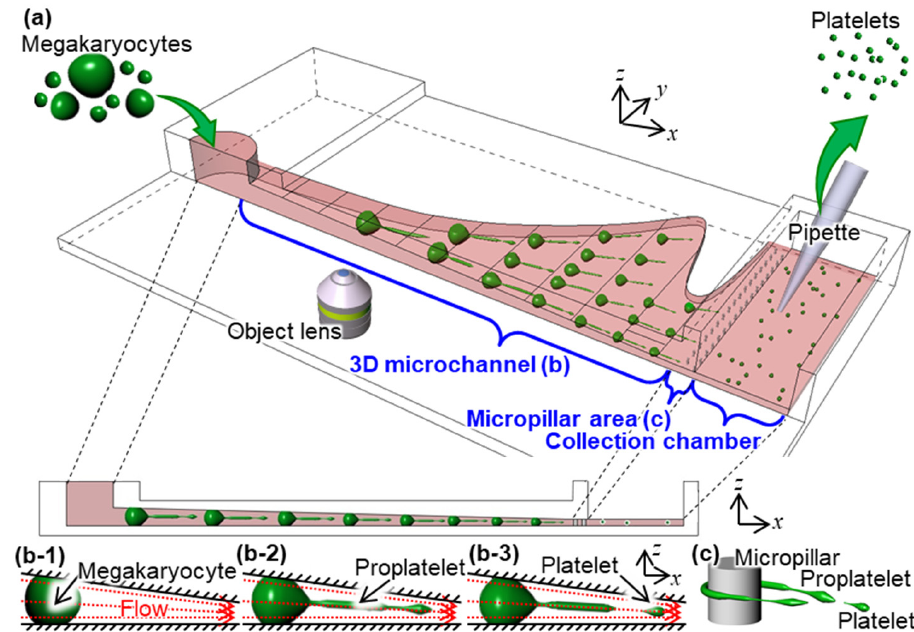
Figure 1. On-chip PLT production using a 3D microchannel. ( a ) Conceptual image of the microfluidic bioreactor, ( b ) Procedures of PLT production of ( b-1 ) The trapping of an MK, ( b-2 ) The elongation of an MK to a PPLT, and ( b-3 ) The fragmentation of a PPLT to a PLT, and ( c ) Trapping of a released PPLT.